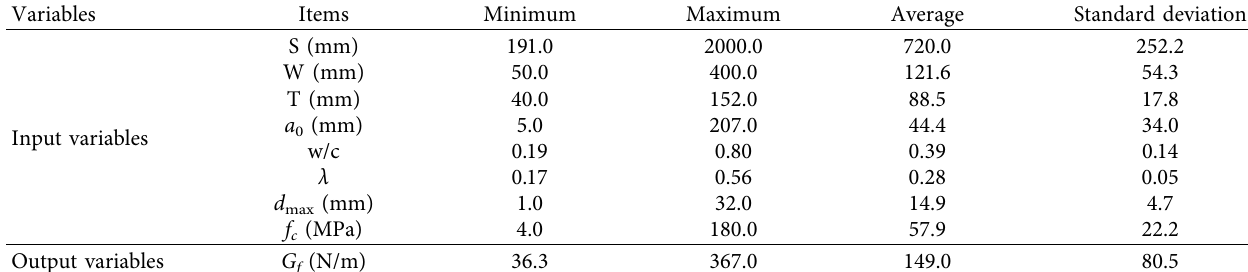
Table 1: Variables of the concrete fracture energy prediction